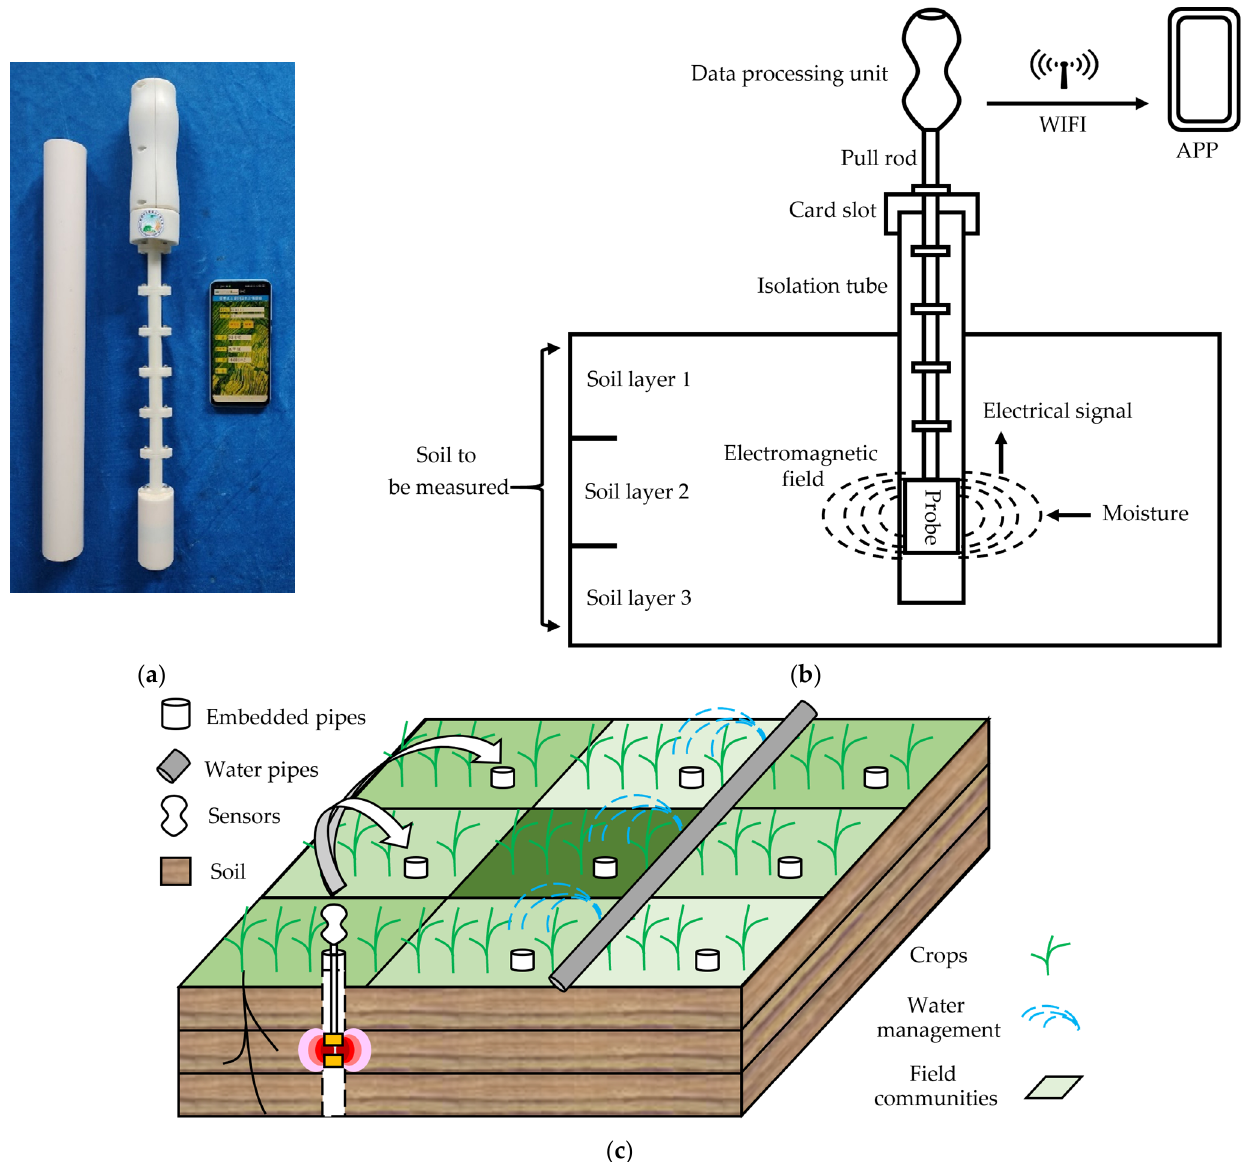
Figure 12. Use of portable pull-out soil profile moisture sensor. ( a ) Physical diagram of the sensor; ( b ) schematic diagram of sensor operation; ( c ) typical application scenarios.